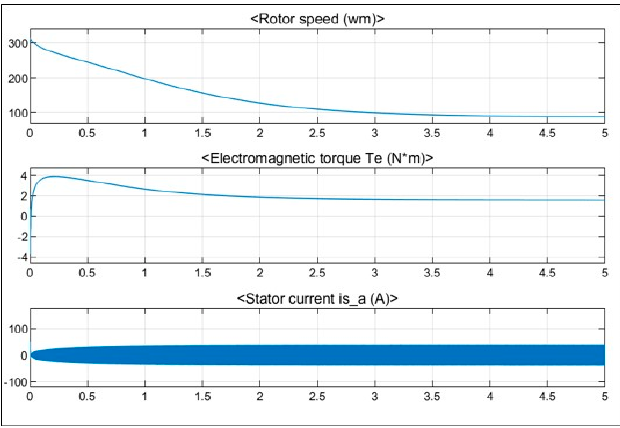
Figure 6. Pump motor characteristics for reduced voltage (F10) .